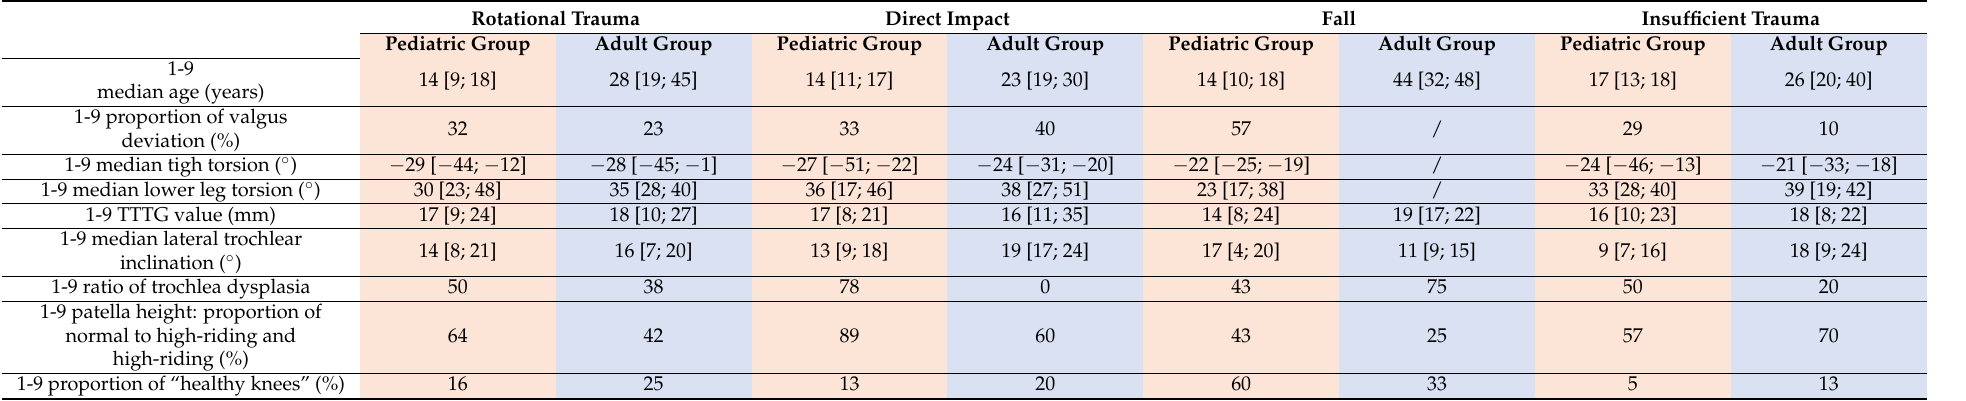
Table 1. The proportion of different predisposing factors and “healthy knees” in the individual trauma categories and age